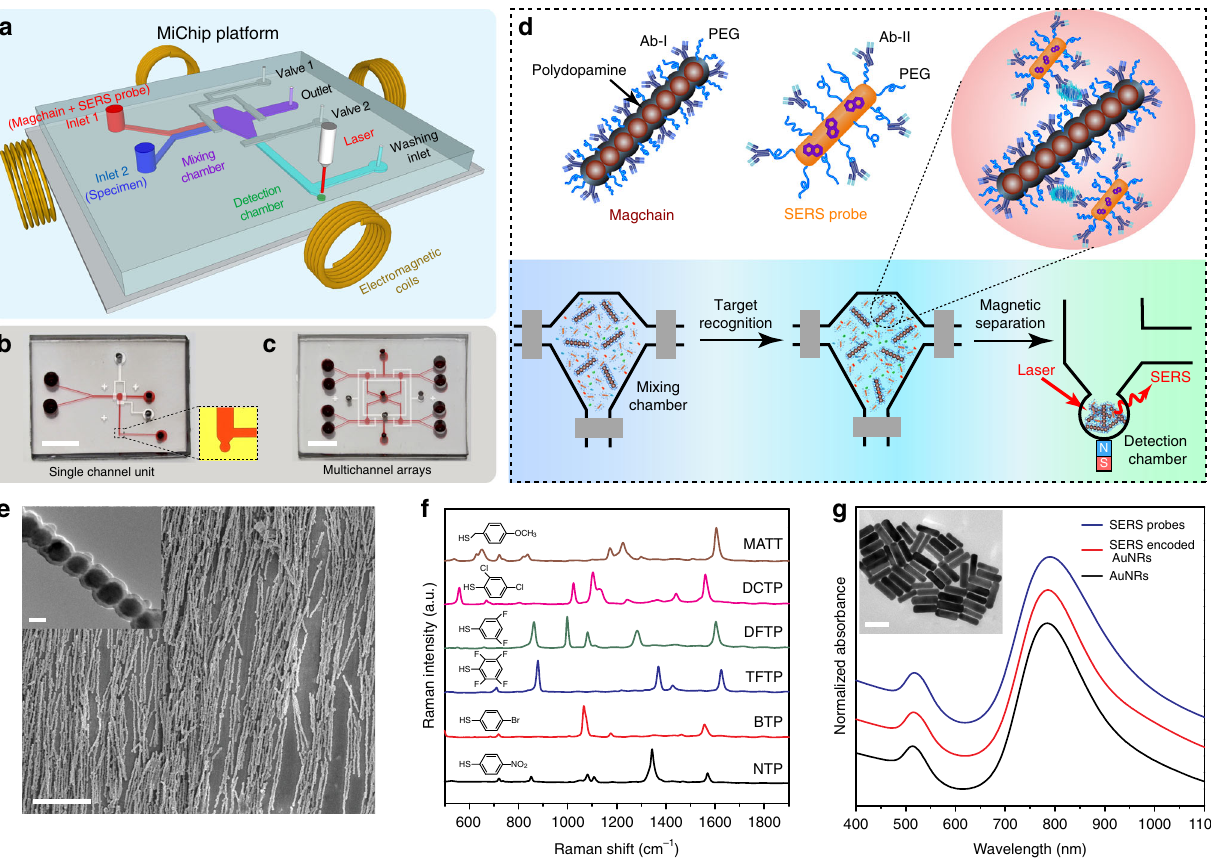
Fig. 1 Design of the magnetic nanochain integrated micro fl uidic chip (MiChip). a Schematic illustration of the MiChip assay platform. b , c Photographs of the MiChip: single channel unit ( b ) and multichannel arrays ( c ). The microchannel was fi lled with a red dye for better visualization. Scale bar: 0.5 cm. d The MiChip assay for the detection of biomarkers. The specimen, antibody-conjugated magnetic nanochains (Magchain) and SERS-encoded probes (SERS probe) are mixed in the mixing chamber. The targets of interest in specimen are recognized by the antibodies on the Magchains and the SERS probes to form sandwich immune complexes. The immune complexes are then isolated into the detection chamber and subjected to Raman spectroscopic detection. e SEM image of the magnetic nanochains. Scale bar: 20 µ m. Inset: TEM image of magnetic nanochain. Scale bar: 200 nm. f SERS spectra of 6 representative SERS-encoded AuNRs. From bottom to top: 4-nitrothiophenol (NTP), 4-bromothiophenol (BTP), 2,3,5,6-tetra fl uorothiophenol (TFTP), 3,5- di fl uorothiophenol (DFTP), 2,4-dichlorothiophenol (DCTP), and 4-methoxy- α -toluenethiol (MATT). g UV – vis spectra of original AuNRs, SERS-encoded AuNR, and antibody-conjugated SERS probes. Inset: TEM image of the AuNRs. Scale bar: 100 groups 29 . As such, the nanochains can be sequentially functio- nalized by target-speci fi c capture antibody (Ab-I) and thiolated non-speci fi c biofouling in complex body fl uids.